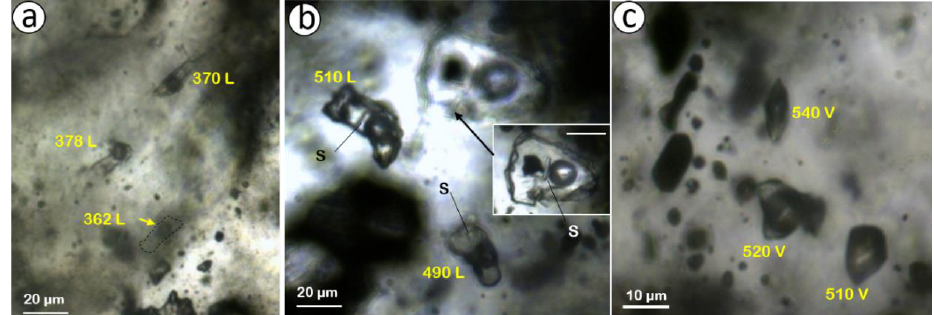
Figure 11. Fluid inclusion assemblages (FIAs) identified at room temperature as ( a ) LV-type in INT#2, ( b ) LVS-type in INT#1, and ( c ) VL-type in INT#2. (S: solid phase; L: homogenization into